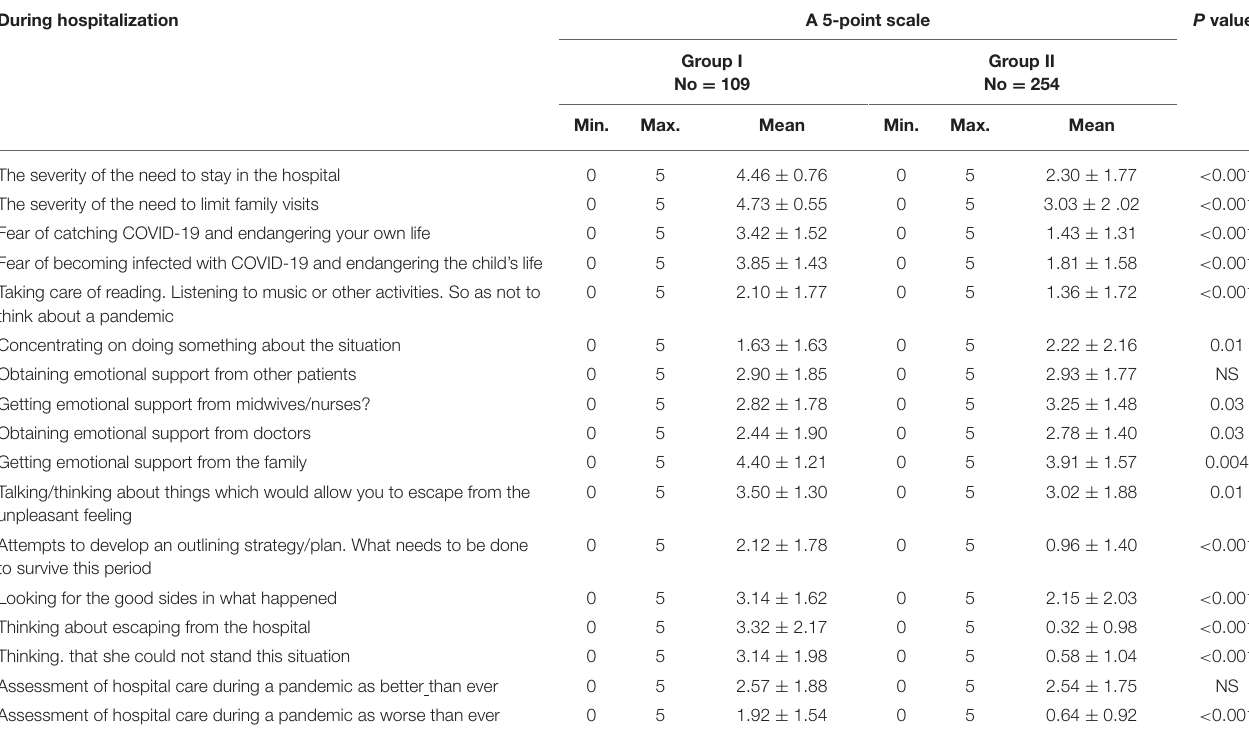
TABLE 1 | Selected aspects of a hospital stay during a pandemic. During